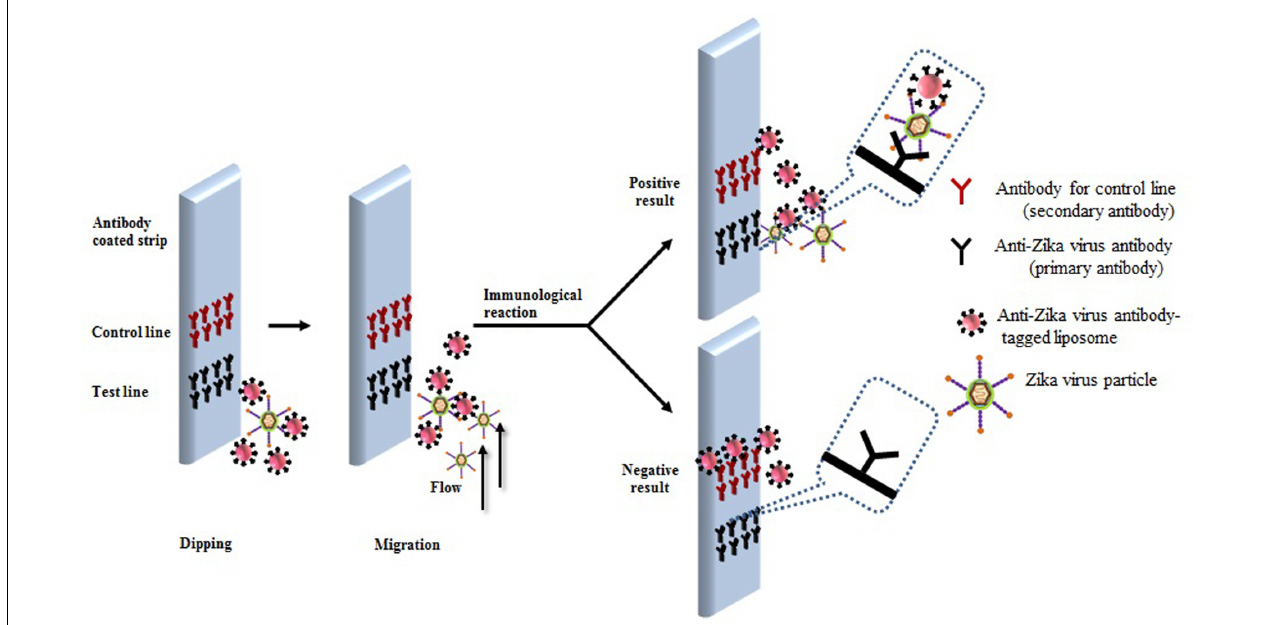
FIGURE 3 | Research theme for developing liposome-based immunochromatographic strips for specific Zika virus.